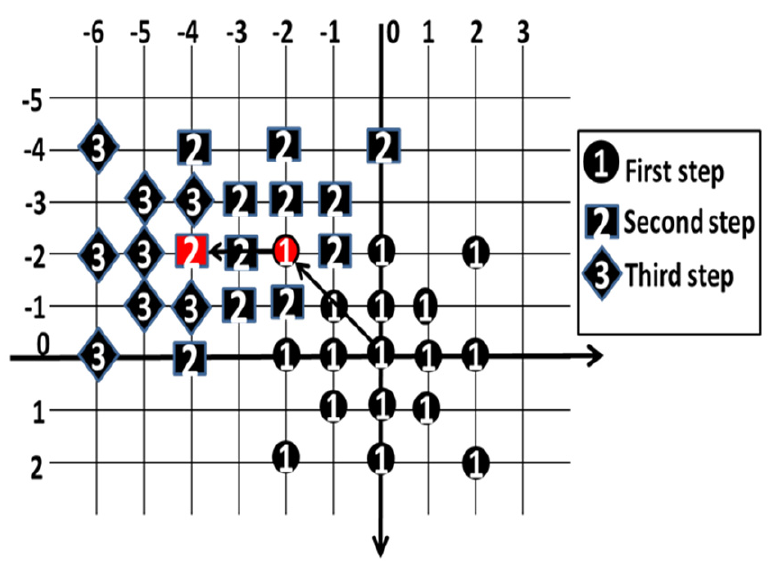
Figure 6 . An illustration of an ADS search algorithm and procedure for searching for the motion vector ( − 4, − 2). Each search point is identi fi ed by a step number and a point with red colour indicates the minimum search point.